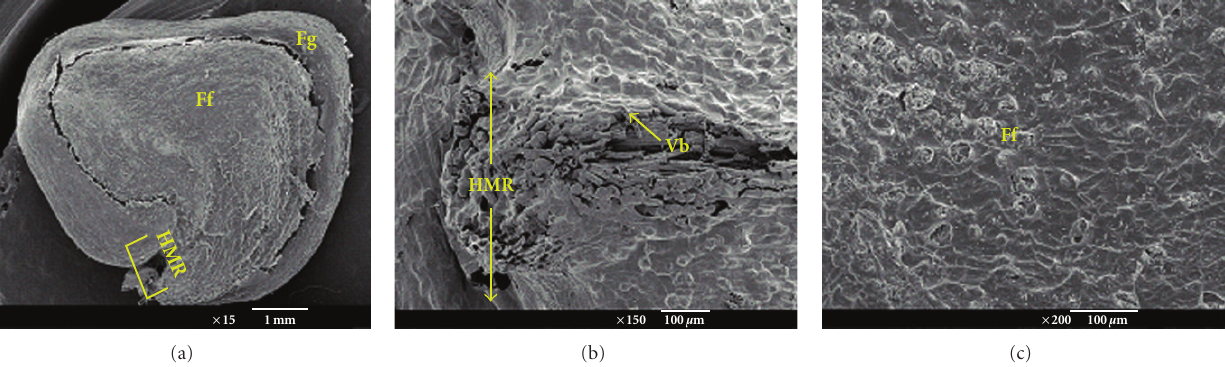
Figure 4: Micrographs of Opuntia tomentosa seeds after two years of laboratory storage: (a) whole seed showing the funicular girdle separated from the remaining funicular seed cover; (b) cracks in the hilum-micropylar region; (c) degradation of the surface layers (cuticle ) of the funicular flanks. Ff: funicular flanks, Fg: funicular girdle, HMR: hilum-micropylar region, Vb: vascular bundles. ( F (2,35) = 8 . 17, P = . 002). Independent of